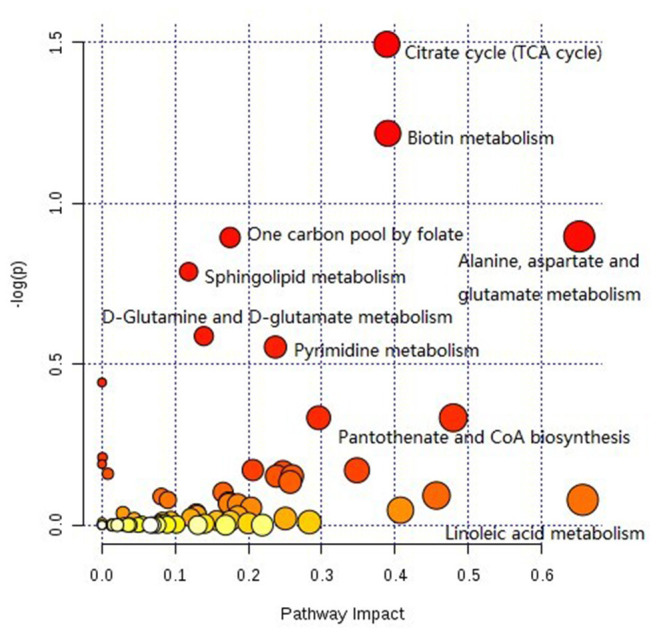
KEGG pathway analysis diagram.